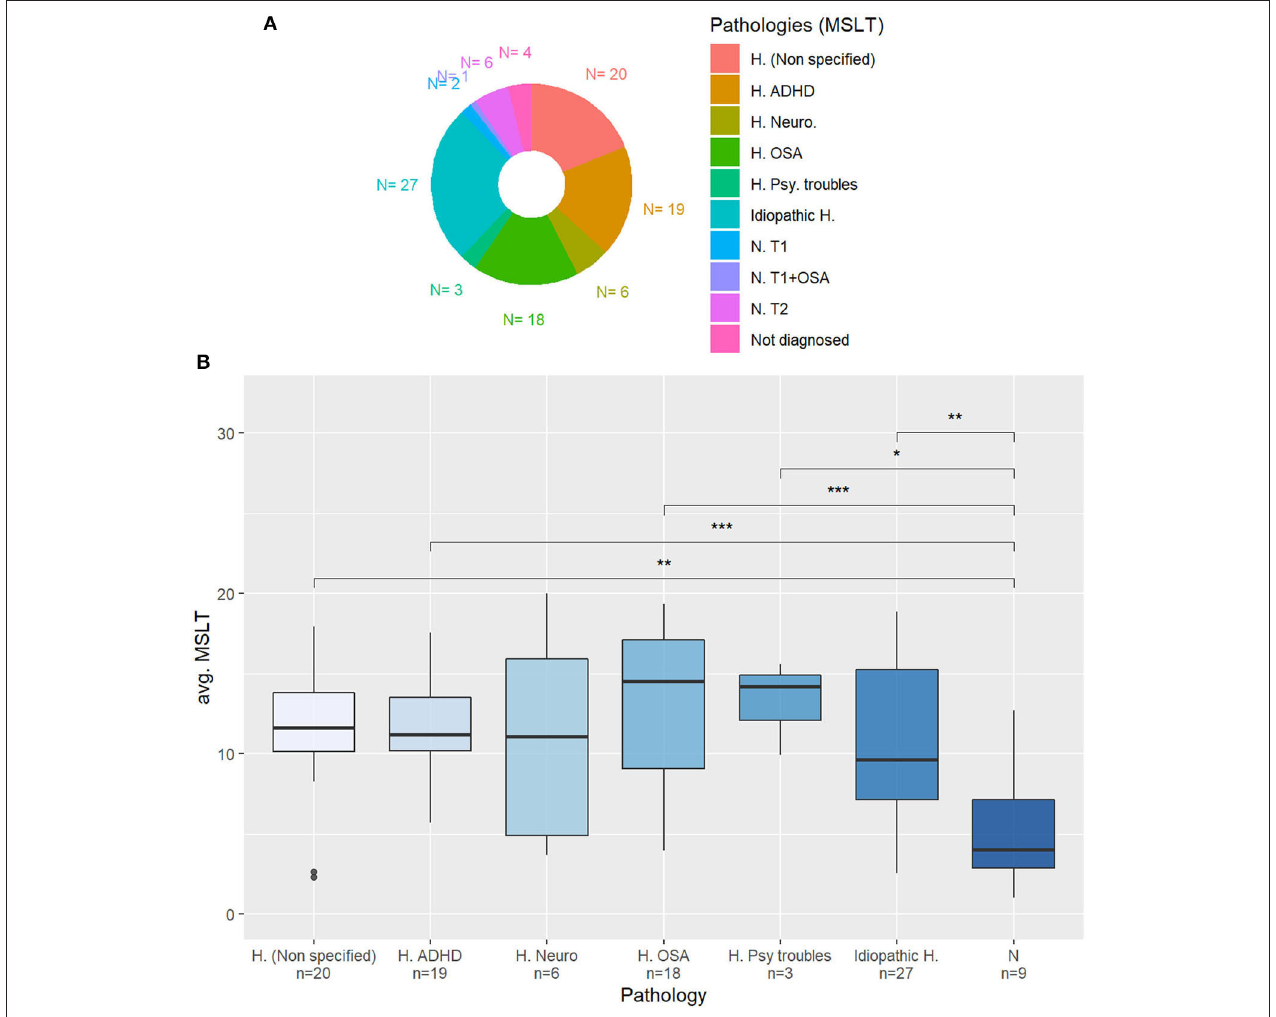
FIGURE 3 | (A) Diagnosed pathology for the patients of the Multiple Sleep Latency Test corpus (MSLTc). H. (Unspecified) : Non-specified hypersomnia (complementary exams needed); H. ADHD : Hypersomnia in an attention-deficit hyperactivity disorder context; H. Neuro : Neurological hypersomnia; H. OSA : Hypersomnia with Obstructive Sleep Apnea; H. Psy. Troubles : Hypersomnia accompanied by psychiatric troubles; Idiopathic H. : Idiopathic Hypersomnia; N. T1 : Type 1 Narcolepsy; N. T1+OSA : Type 1 Narcolepsy + OSA; N. T2 : Type 2 Narcolepsy; Not diag. : Not yet diagnosed. (B) Averaged MSLT sleep latencies depending on the pathology. N: Narcolepsy. Mann-Whitney’s U -test: * p < 0.05; ** p < 0.01; *** p <